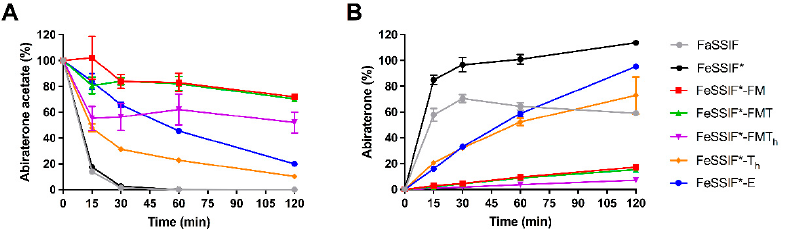
Figure 2. Concentration-time profiles of the degradation in abiraterone acetate ( A ) and the corresponding formation of abiraterone ( B ) in FaSSIF and fed state simulated media supplemented with porcine esterases (80 IU/mL). Concentrations are given as percentage of the molar start concentration of abiraterone acetate. In the media containing lipids, concentrations in the total sample (i.e., micellar + lipid layer) are presented. Data represent mean ± SD (n = 3). (F = fatty acids, M = monoglycerides, T = triglycerides, T h = high triglycerides, E = Ensure Plus).